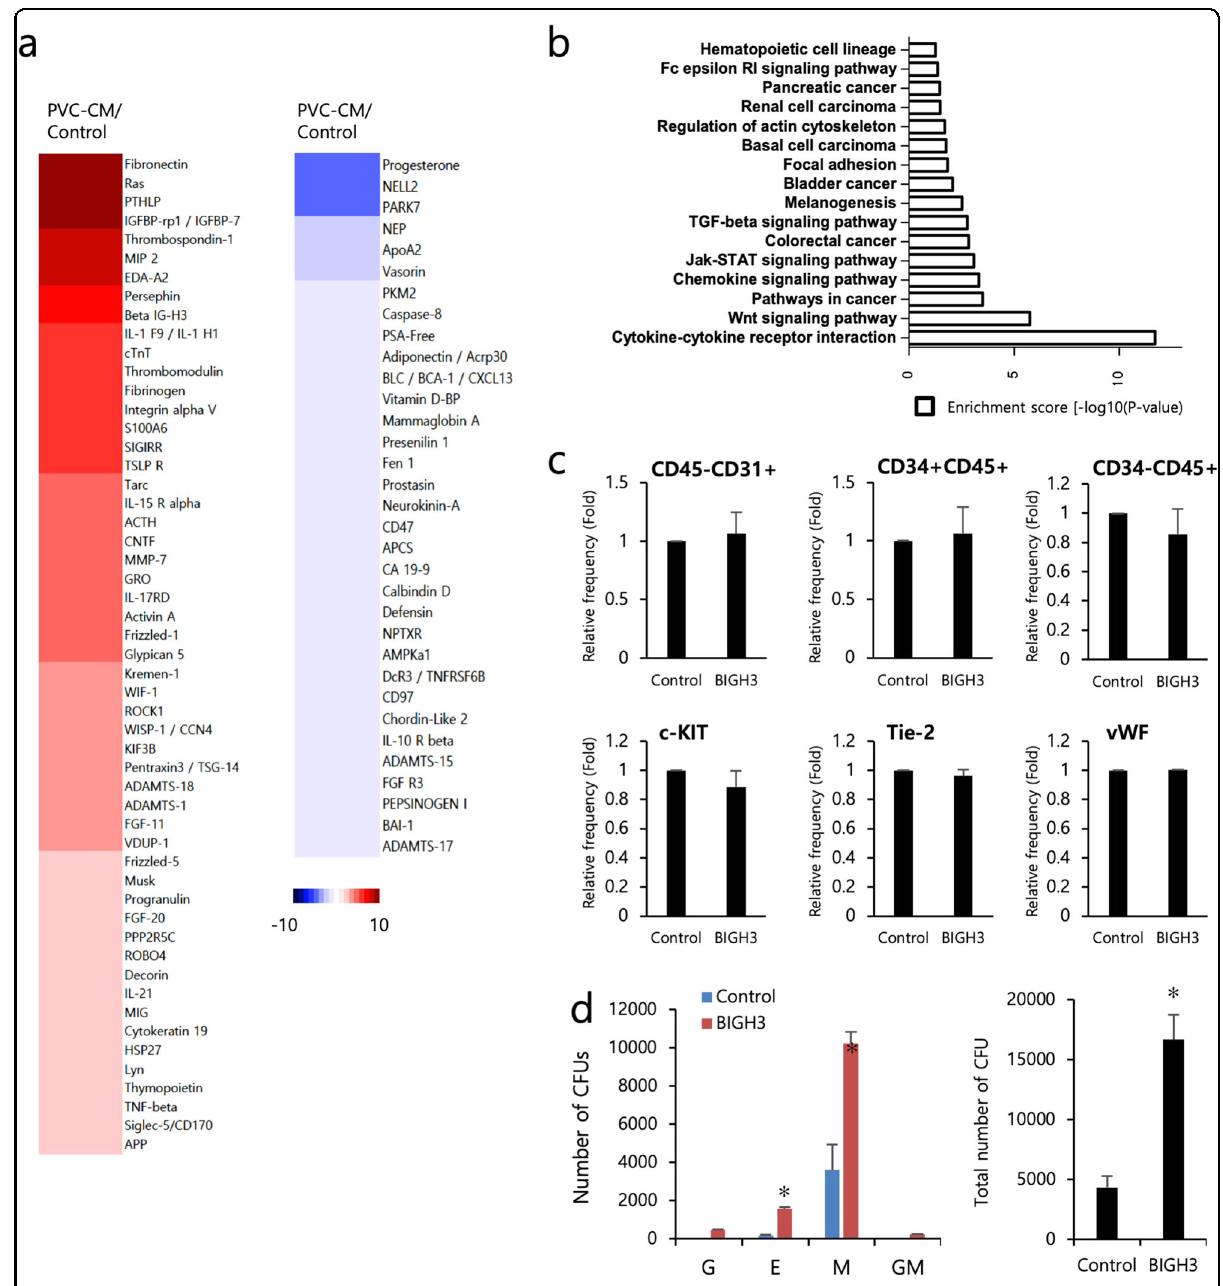
Fig. 5 Protein array analysis reveals the secretion of ECM proteins, including BIGH3. a Heatmaps for upregulated and downregulated proteins in PVC-CM compared to the control. The color spectrum from blue to red indicates low to high expression. b Molecular and cellular functions associated with PVC-secreted proteins. c Flow cytometry (upper) and qRT-PCR (lower) analysis revealed that supplementation with BIGH3 during the hematopoietic commitment phase (days 9 – 17) did not enhance the production of hematopoietic or endothelial lineage cells. d Cultures differentiated with BIGH3 produced more CFU-E and CFU-M colonies than the control cultures. The bars indicate the mean ± SD; * p <